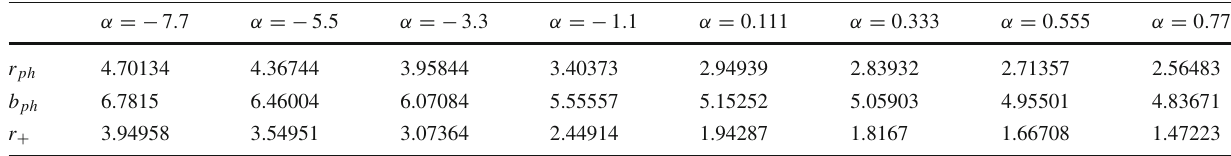
Table 1 The radius r ph , impact parameter b ph of the photon sphere and the event horizon r + for different α with M = 1 α = − 7 .